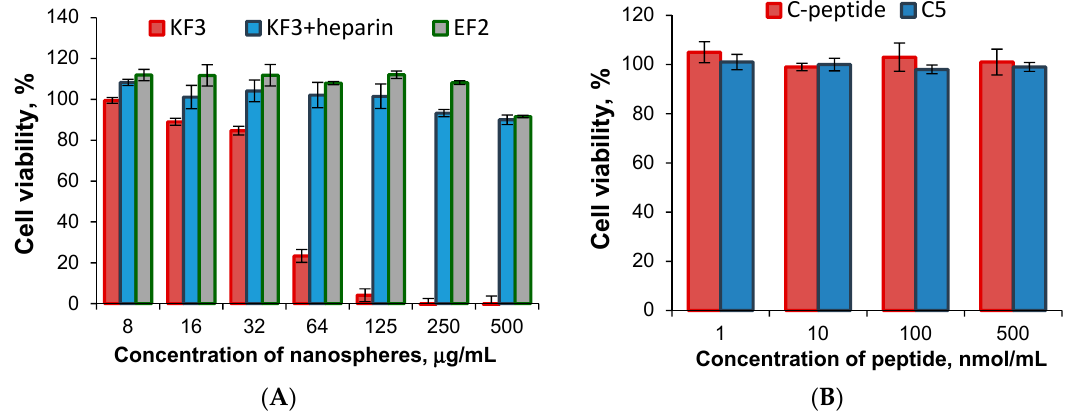
Figure 10. Cell viability (HEK-293) after their incubation for 3 days in presence of different nanospheres ( A ); C-peptide and C5 peptide ( B ).